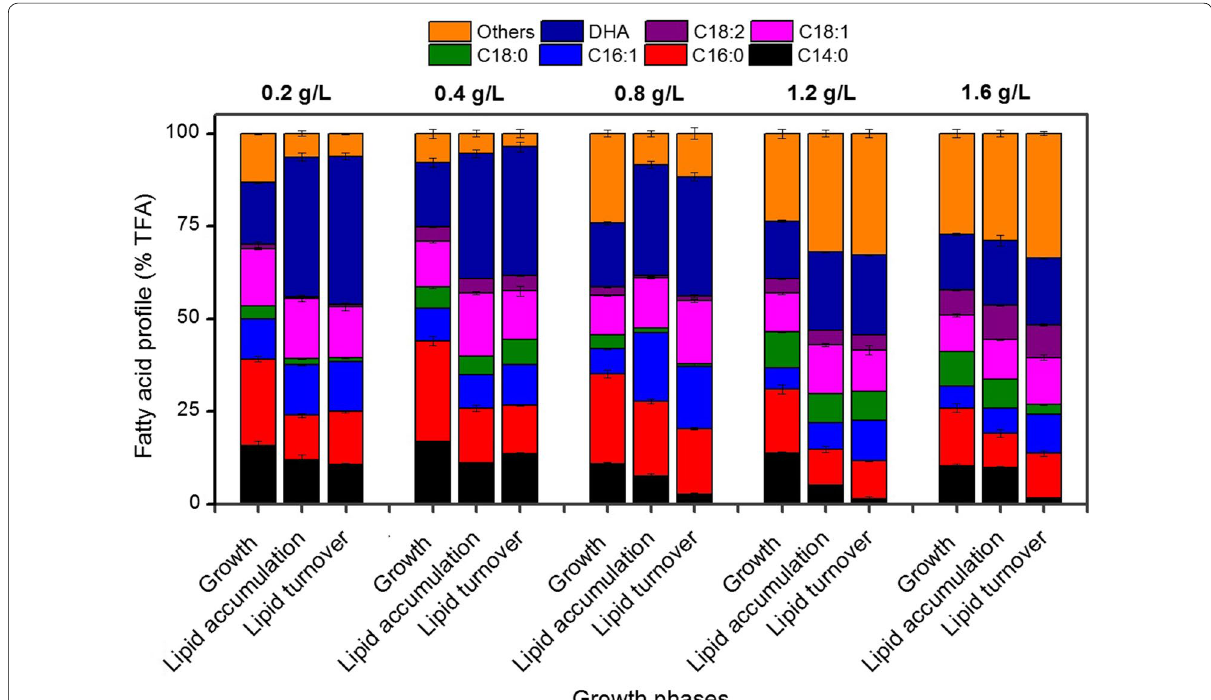
Fig. 5 Fatty acid profile of C. cohnii under different NaNO 3 concentration in three growth stages; cell growth, lipid accumulation and lipid turnover stage harvested on 48, 120 and 168 h, respectively. All experiments were performed in triplicate. The data presented here is mean